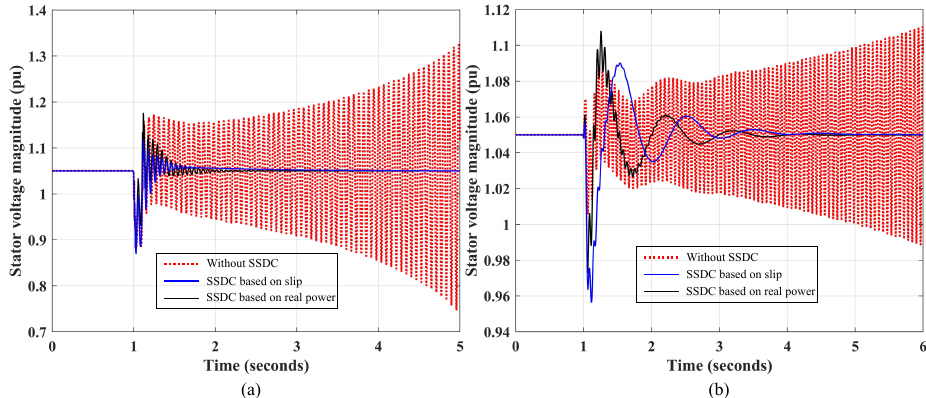
Figure 14. Stator voltage magnitude of system in response to a ( a ) grid voltage disturbance, and ( b ) grid frequency disturbance.